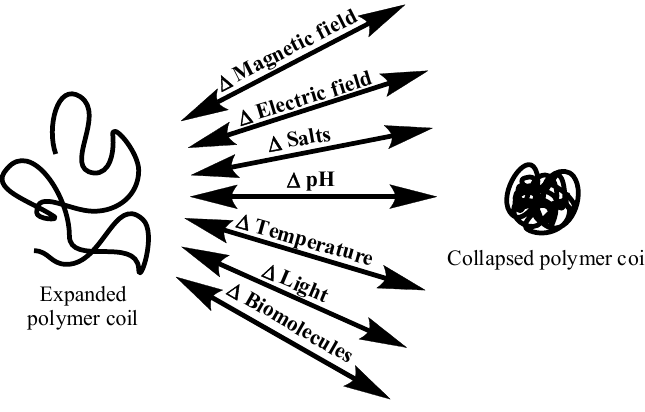
Figure 1. Stimuli-response behavior of polymer chains in response to various external stimuli.